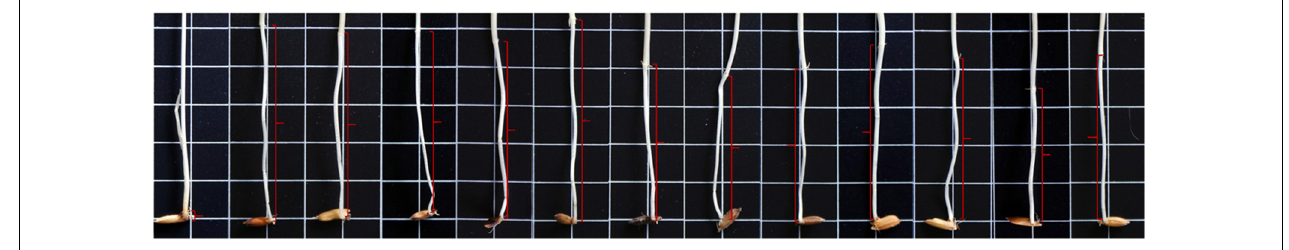
FIGURE 1 | Mesocotyl ( red brackets ) length of “IR 145” and the 12 male parents of the F 2 populations. The 13 individuals were “IR 145” (0.18 cm) and the corresponding male parents of Pop1 to Pop12 (from left to right ) were as follows: 79 (5.13 cm), Bamla Suffaid 32 (4.80 cm), M 136–20 (4.67 cm), Cash (4.75 cm), Balam 2 (4.83 cm), Kalasu (4.20 cm), Black 28–573 (3.39 cm), Bhahuri (4.18 cm), Changai (4.74 cm), Basmati 385 (4.68 cm), IR 64 (3.48 cm), and BR 11 (4.24 cm).